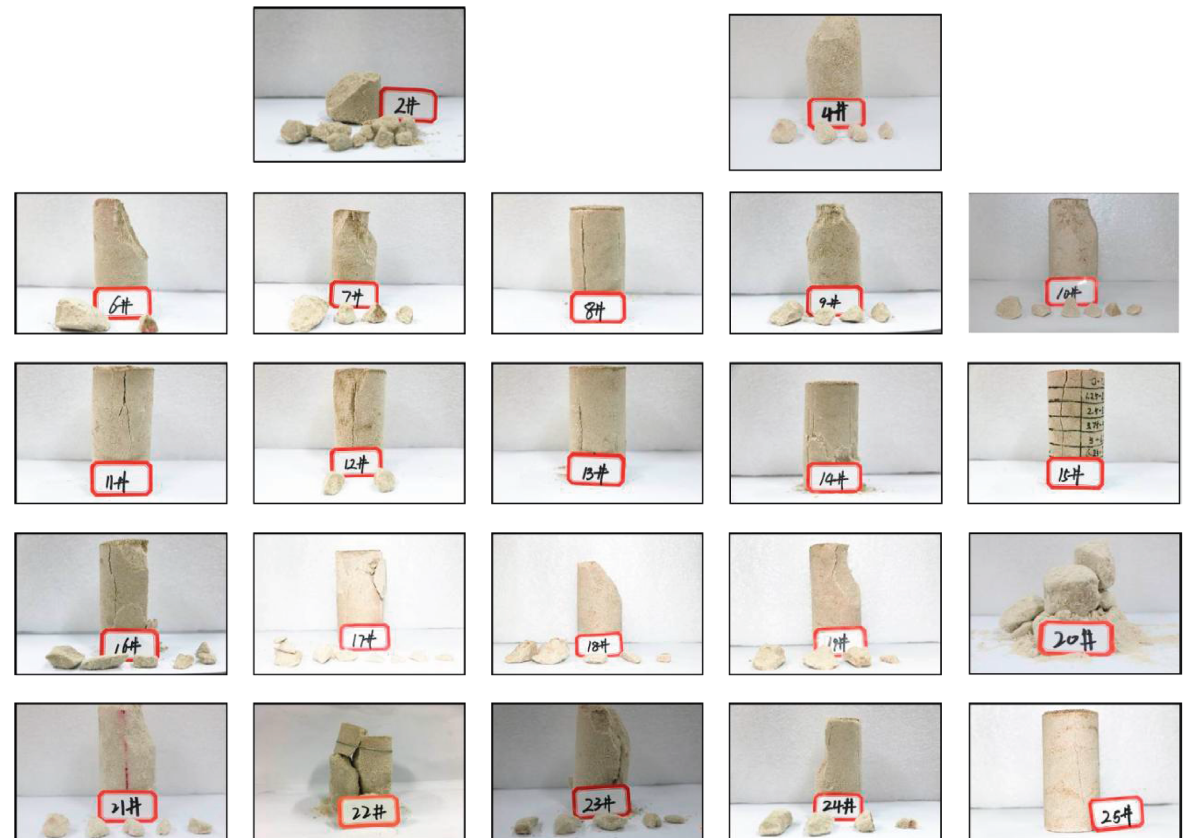
Figure 4: Picture of the uniaxial compression failure of the cemented sand column under different control